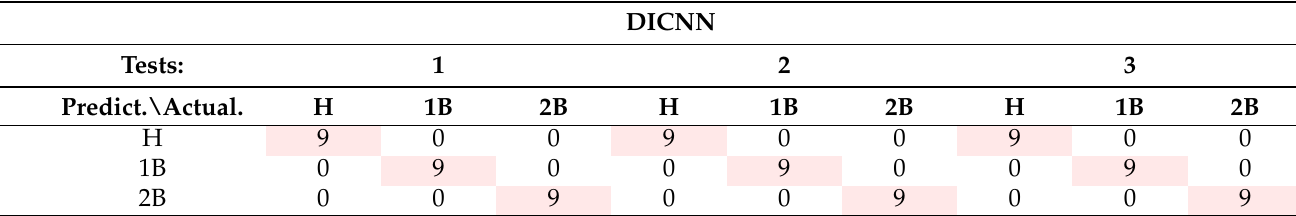
Table 9. Confusion matrix of the DICNN model with fault type classification.